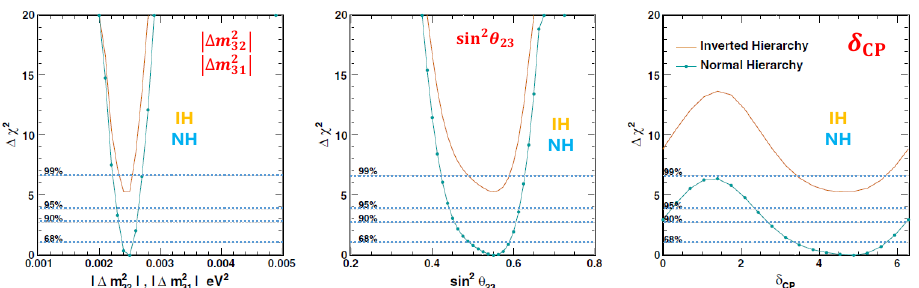
Figure 2. The constraint on the neutrino parameters from a combined fit with SK atmospheric neutrino data and the model of T2K experiment assuming sin 2 θ 13 = 0.0219 ± 0.0012 [44]. The original figure is adapted from Ref. [14].